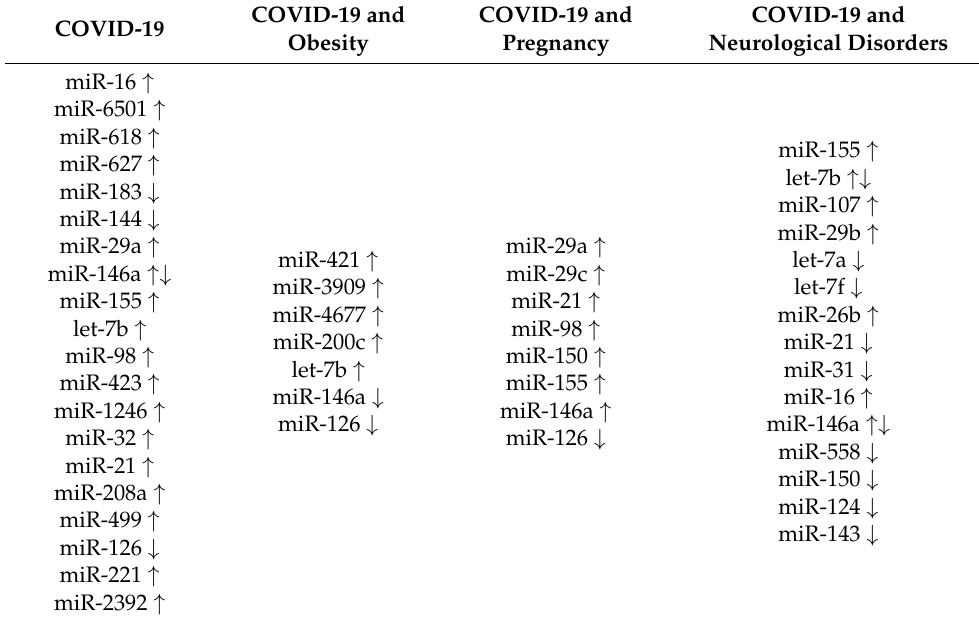
Table 1. Selected miRNAs differentially expressed in patients with COVID-19 and patients with COVID- 19 and conditions: obesity, pregnancy or neurological disorders. ↑ —upregulated; ↓